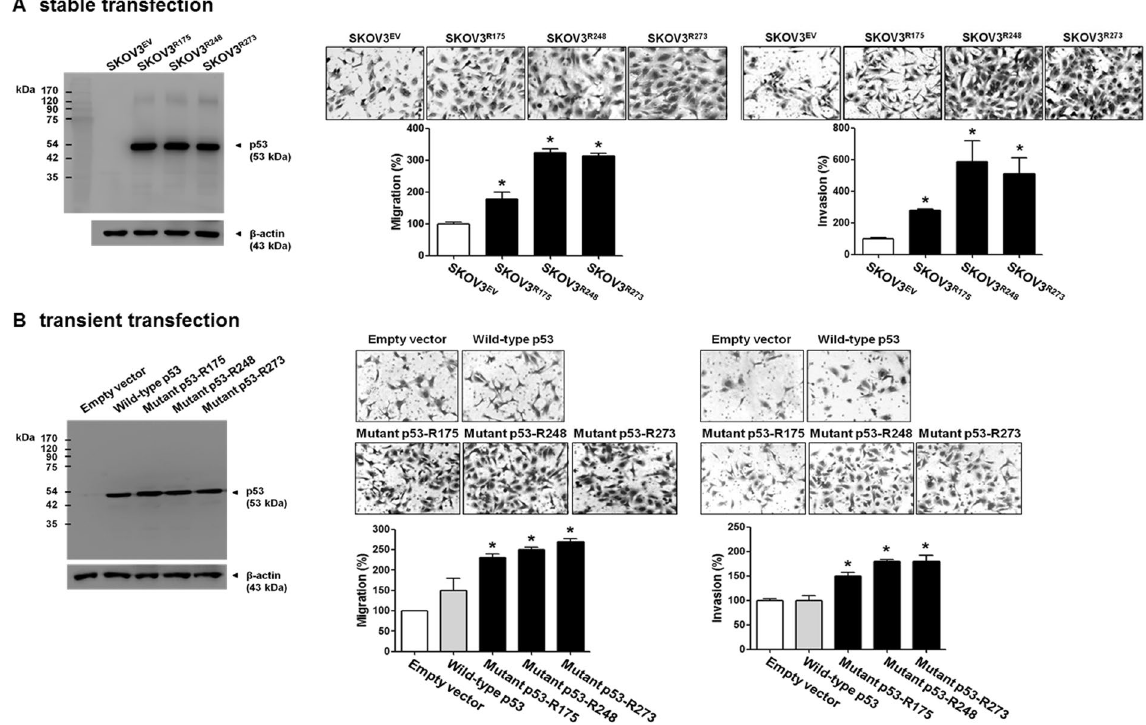
Figure 1. The effect of ectopic expression of p53 mutants on cell migration and invasion in p53-null SKOV3 cells. ( A ) A western blot assay was performed to measure the p53 protein levels in stably transfected SKOV3 EV , SKOV3 R175 , SKOV3 R248 , and SKOV3 R273 cells. β -Actin was used as an internal control. The cells were seeded in uncoated chambers for the migration assay and incubated for 24 h or seeded in Matrigel-coated chambers for the invasion assay and incubated for 48 h. ( B ) A western blot assay was performed to measure the p53 protein levels after SKOV3 cells were transiently transfected with empty vector, wild-type p53, p53-R175, p53-R248, and p53-R273. β -Actin was used as an internal control. The SKOV3 cells were seeded in uncoated chambers for the migration assay and incubated for 24 h or seeded in Matrigel-coated chambers for the invasion assay and incubated for 48 h. Representative images show the migrating and invading cells. Results are the combined data (mean ± S.D.) from three independent experiments. * P < 0.05 compared with the SKOV3 EV group or the empty vector